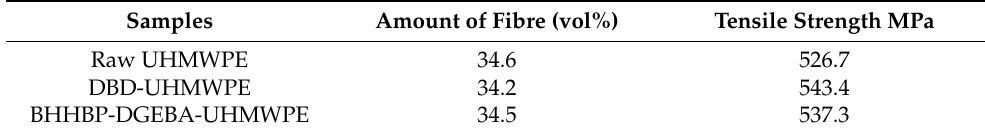
Table 5. Mechanical strength comparison of untreated and treated UHMWPE [41]. Samples Amount of Fibre (vol%) Tensile Strength MPa Raw